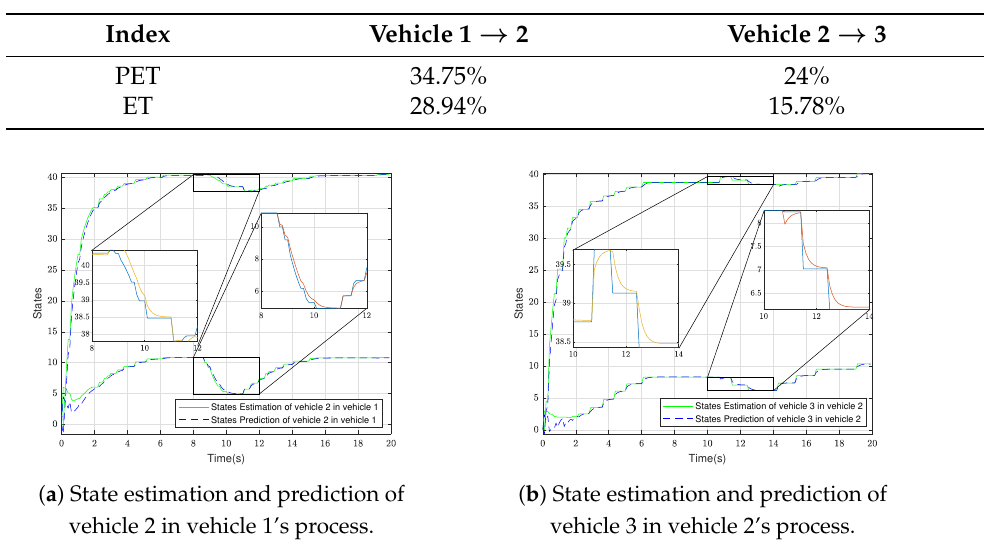
Table 3. J net index for the simulation.